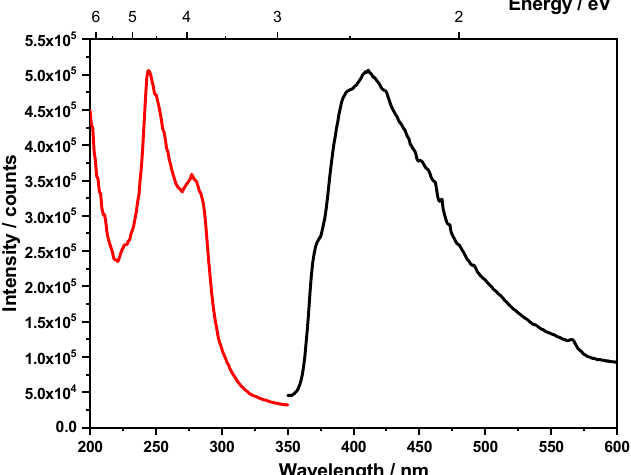
Figure 11. Room-temperature emission spectrum (black) under 280 nm excitation and the excitation spectrum (red) monitored at 420 nm of a white powder sample of Tl[CB 11 H 12 ].